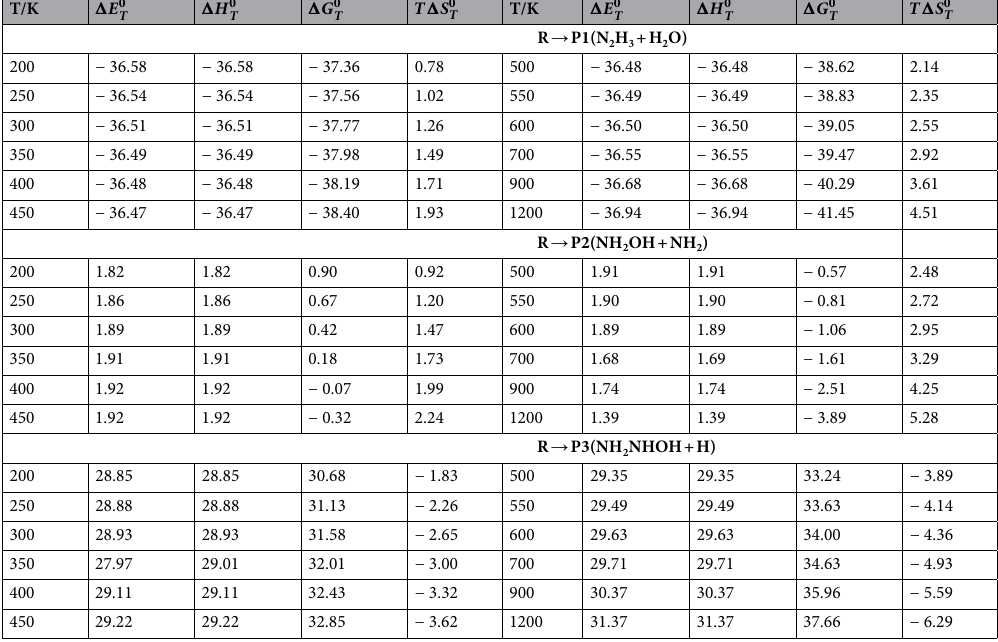
Table 4. The thermodynamic parameters (kcal mol −1 ) of the P1–P3 adducts of the N 2 H 4 + OH reaction on the doublet potential energy surface at the CCSD(T)/CBS (energy) + UMP2/aTZ (corrections) level.